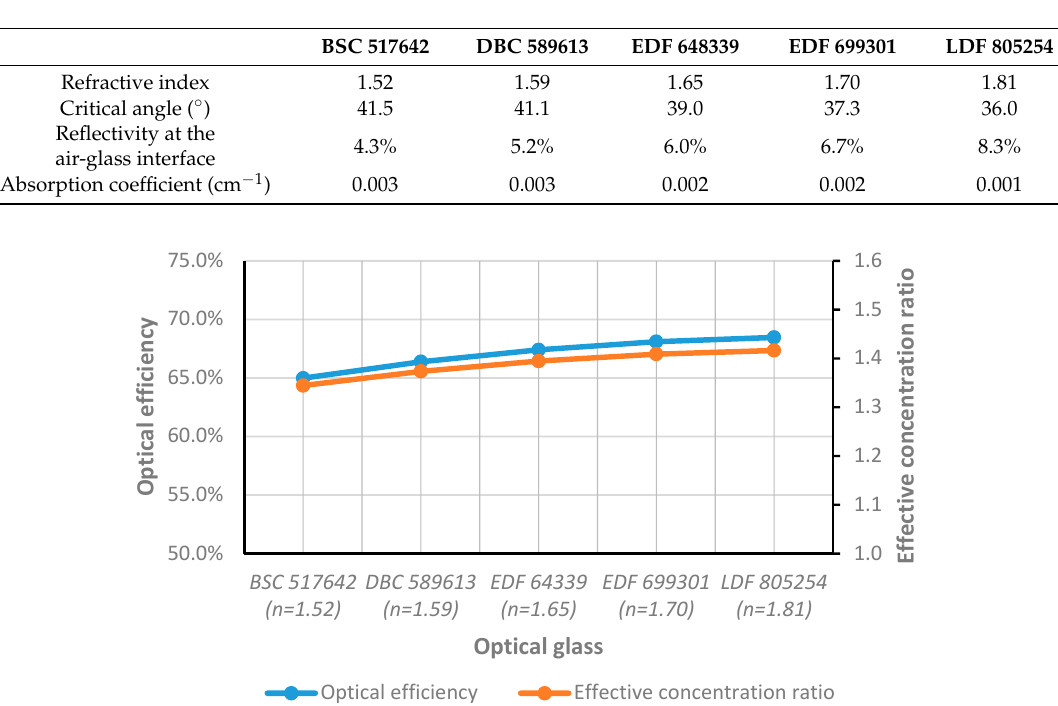
Figure 7. The optical efficiency and effective concentration ratio as a function of the diffuse reflectivity of the opaque and semi-transparent reflectors.